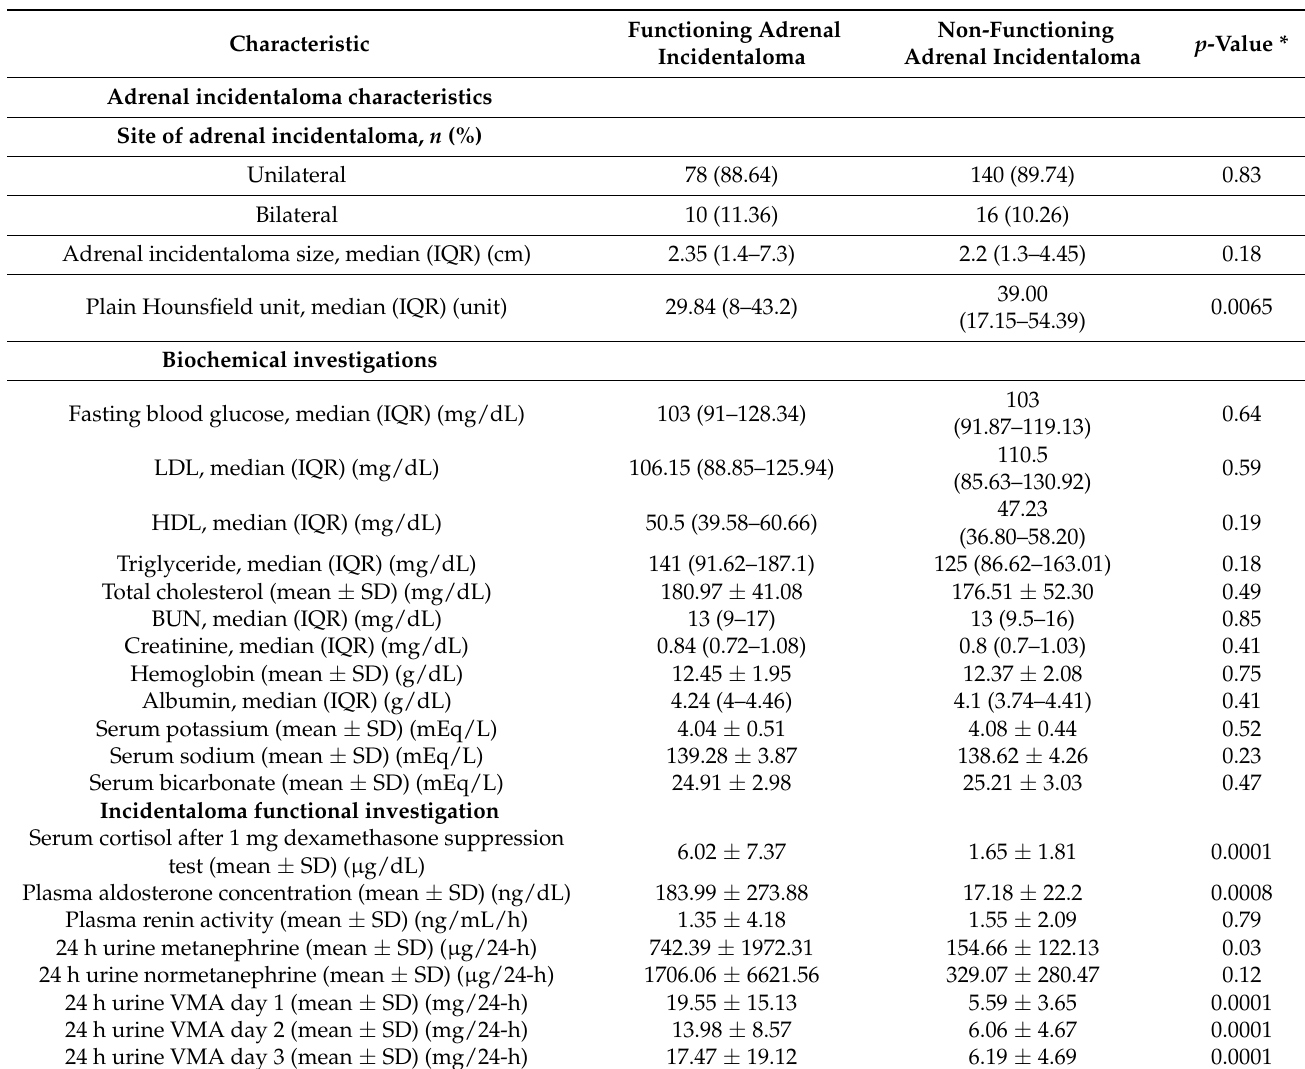
Table 2. Baseline investigations of patients with functioning adrenal incidentaloma ( n = 88) and non-functioning adrenal incidentaloma ( n = 156).